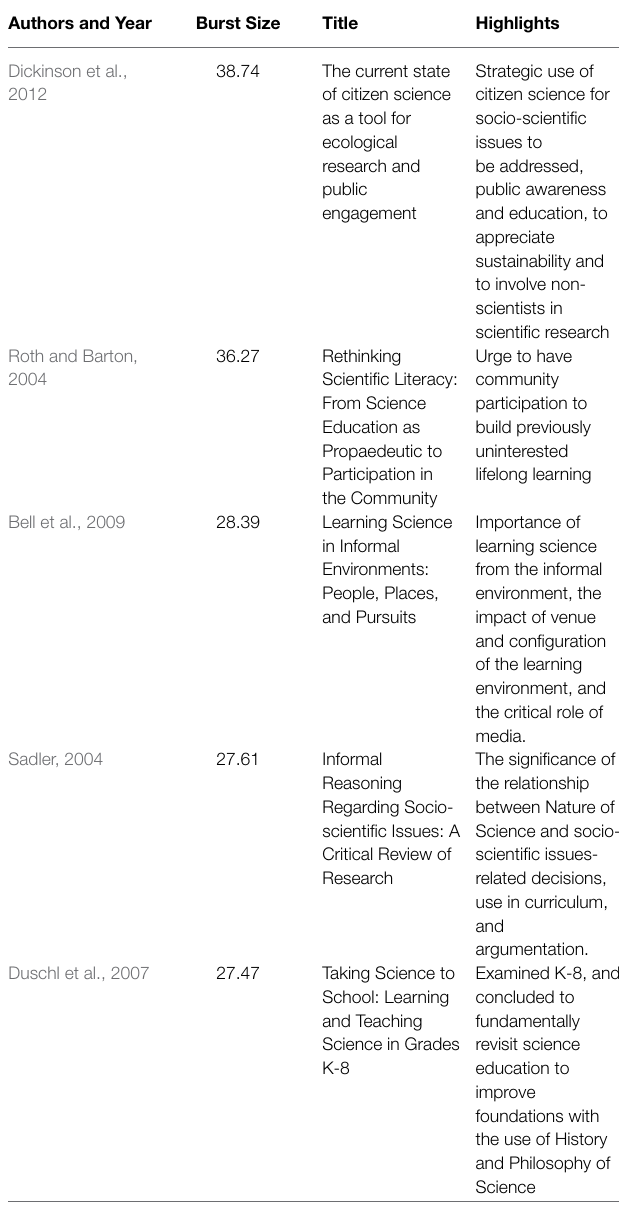
TABLE 1 | Top 5 article co-citation bursts in the literature of scientific literacy between the years 1980 to